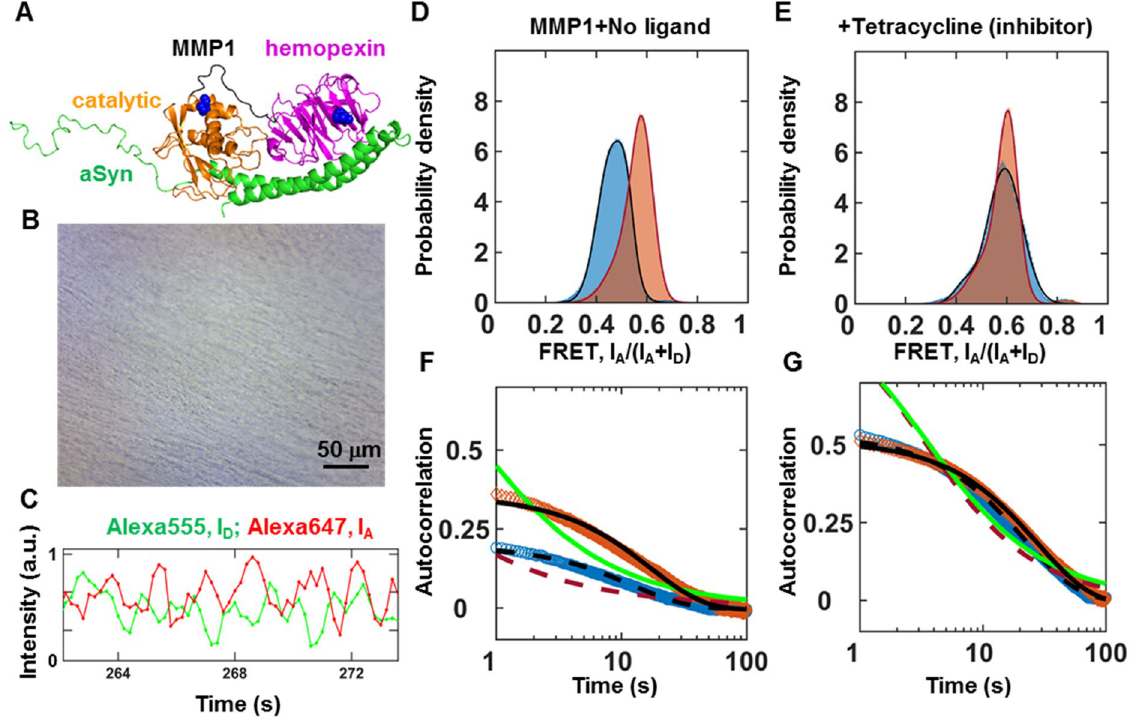
Figure 1. Activity-dependent interdomain dynamics of MMP1 on aSyn-induced aggregates at 22 ºC with 100 ms time resolution. ( A ) One of many predicted binding poses between MMP1 (PDB ID 4AUO; catalytic: orange; linker: black; hemopexin: magenta; S142C and S366C mutations in blue) and aSyn (PDB ID 1XQ8; green). ( B ) Light microscopy image of aSyn-induced aggregates on a slide. For MMP1-treated aggregates, see Fig. S1. For Transmission Electron Microscopy images of aggregates, see Fig. S2. ( C ) Emission intensities of the two dyes attached to active MMP1. ( D , E ) Area-normalized histograms of MMP1 interdomain distance (~ 200,000 FRET values, bin size = 0.005) without ligand and in the presence of tetracycline (an inhibitor), respectively, for active (blue) and inactive (orange) MMP1. All histograms are fitted to a sum of two Gaussians [Eq. (1) in methods] (active: solid blue line; inactive: solid red line). ( F ) and ( G ) Autocorrelations [Eq. (2) in methods] of MMP1 interdomain distance without ligand and in the presence of tetracycline, respectively, for active (blue) and inactive (orange) MMP1. All autocorrelations are fitted to exponentials and power laws [Eq. (3) in methods] (exponential fit to active: dashed black line; power law fit to active: dashed red line; exponential fit to inactive: solid black line; power law fit to inactive: solid green line). The error bars in histograms and autocorrelations represent the square roots of the bin counts and the standard errors of the mean (SEM) and are too small to be seen. For best-fit parameters, see Table